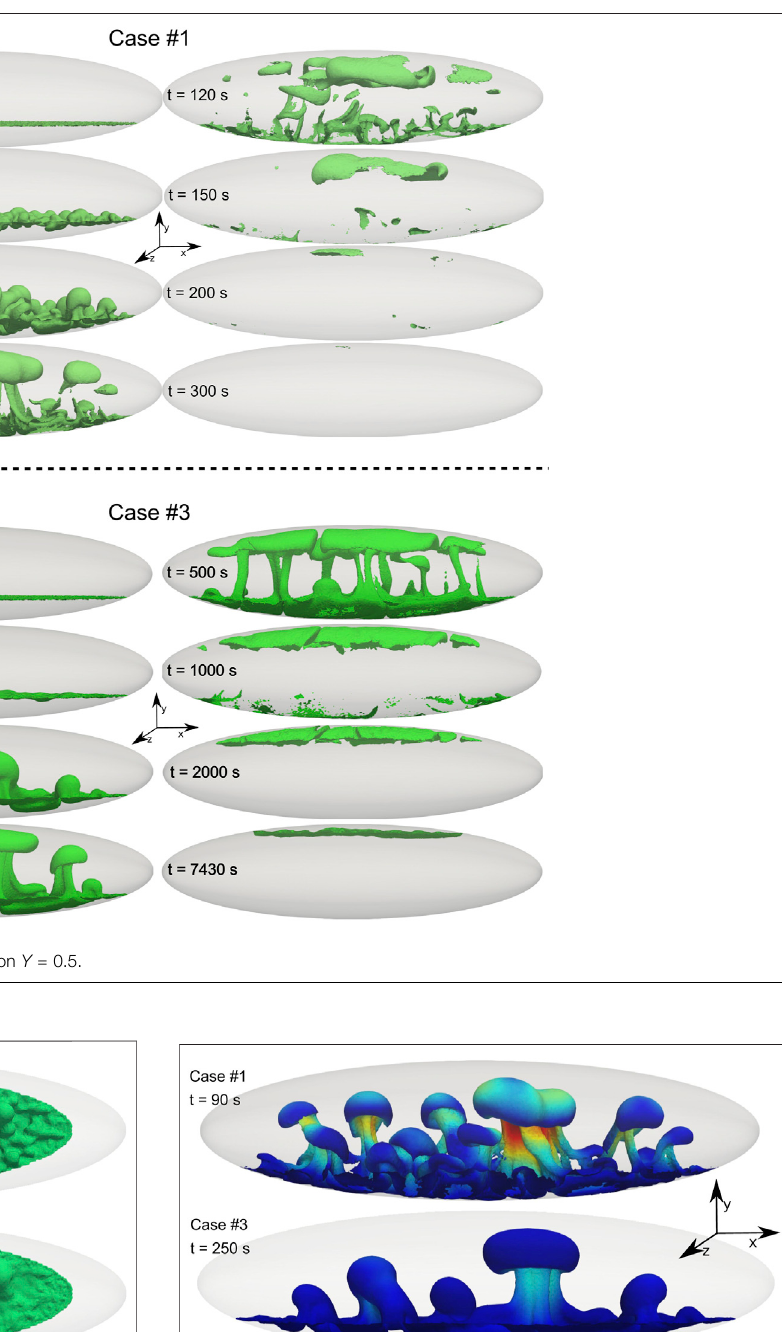
Frontiers in Earth Science |